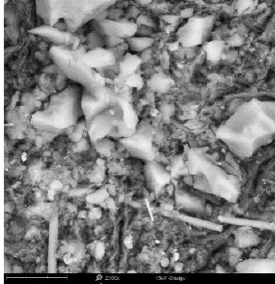
Figure 4. SEM image of modified SiO 2 aerogel in the waterborne coating system.